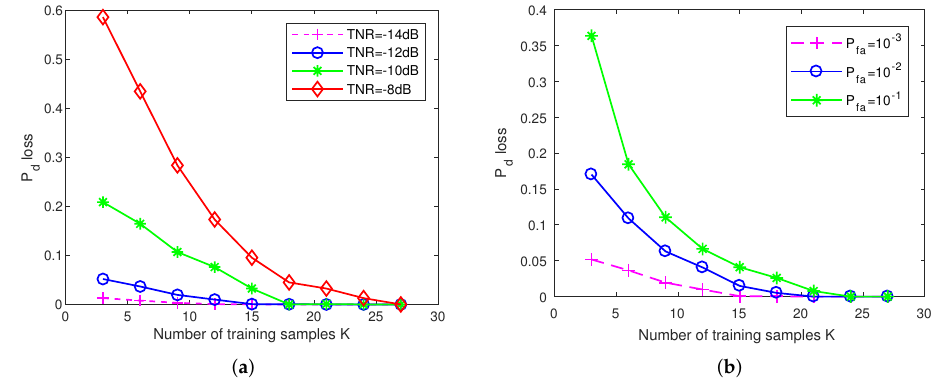
Figure 6. The P d loss of the proposed method. ( a ) DNR = − 30 dB, P fa = 10 − 3 . ( b ) DNR = − 30 dB, TNR = − 12